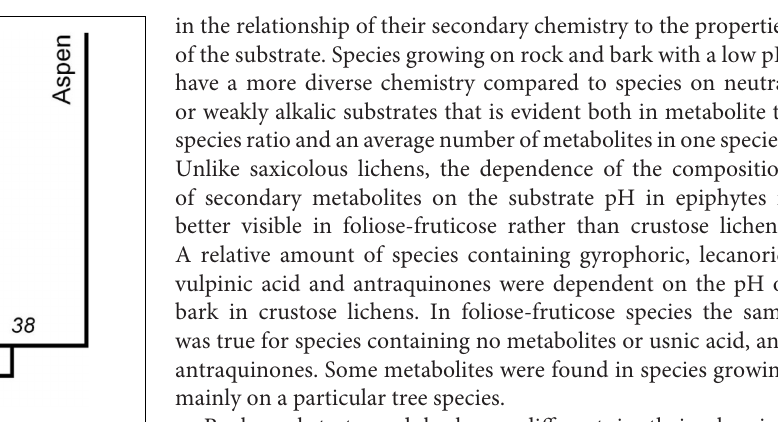
FIGURE 4 | Similarity dendrogram of chemical composition of bark of five phorophytes based on the Sørensen’s coefficient of